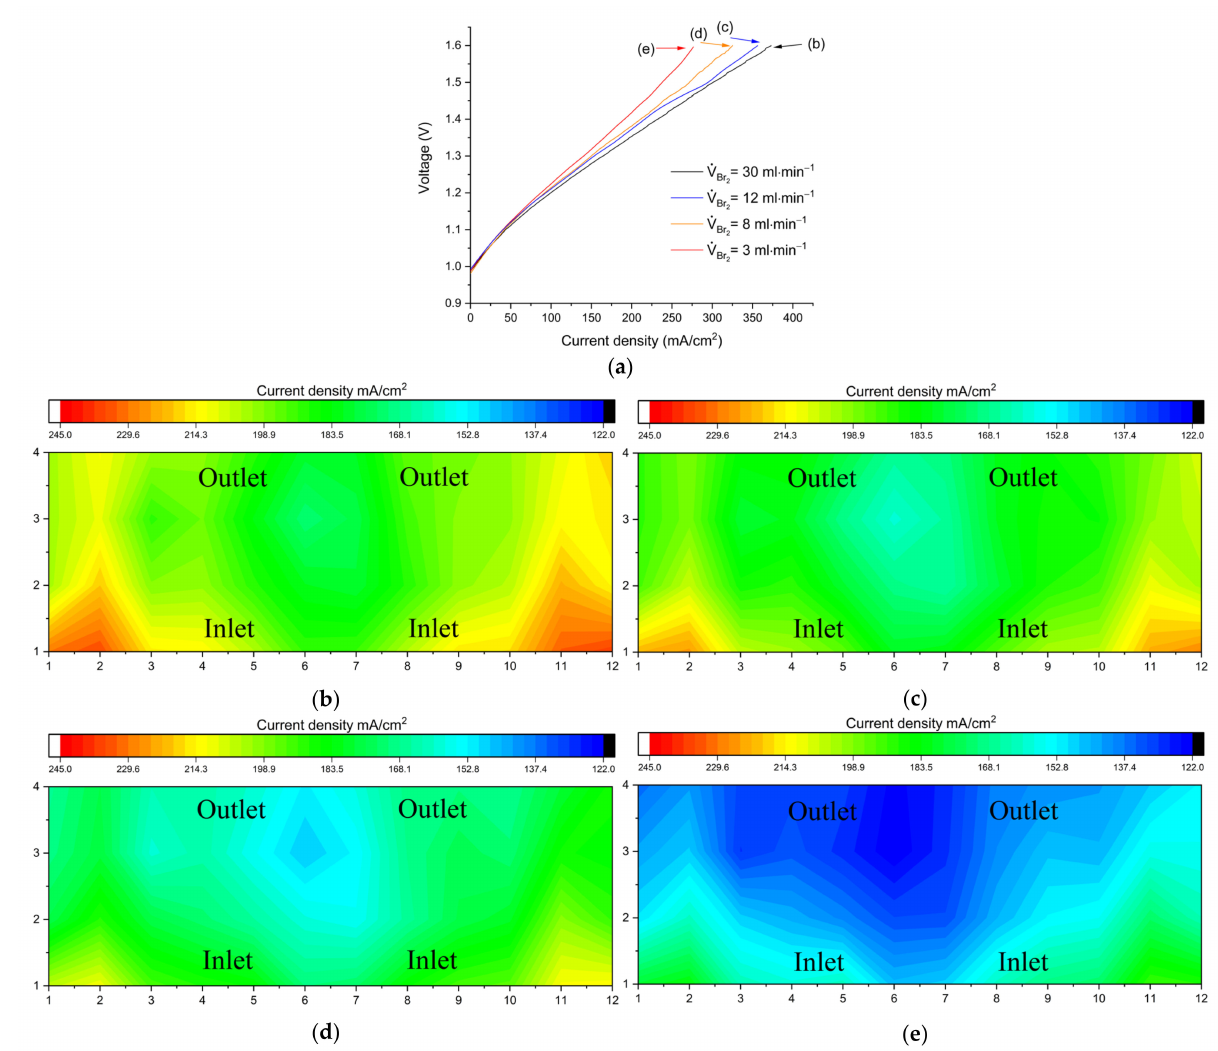
Figure 7. ( a ) Polarization curves (charge) for different stoichiometric flow factors and corresponding current distributions at limiting conditions for ( b ) V Br2 = 30 mL min − 1 , ( c ) V Br2 = 12 mL min − 1 , ( d ) V Br2 = 8 mL min − 1 , and ( e ) V Br2 = 3 mL min − 1 . The supply of H 2 was fixed to V H2 = 170 mL min − 1